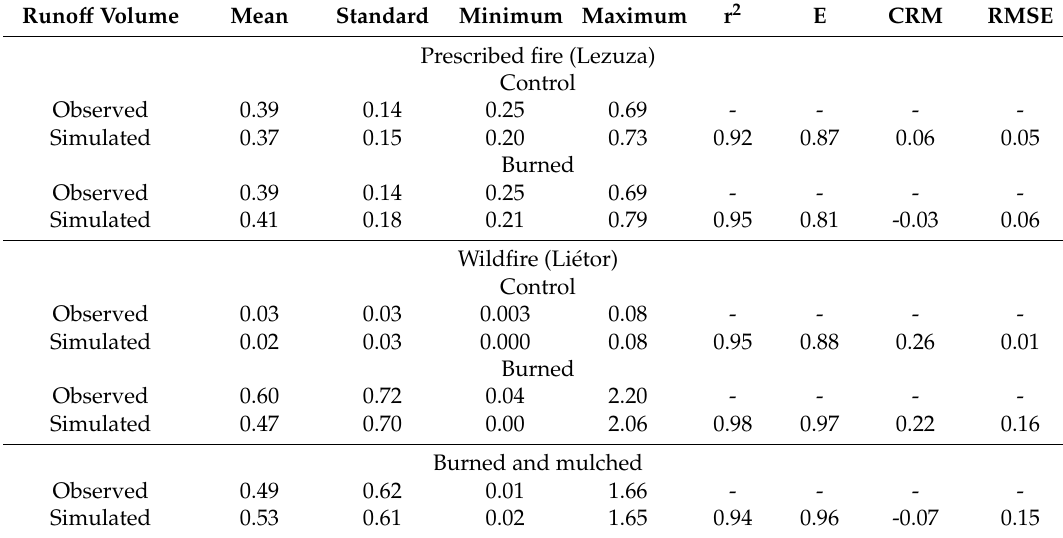
Table 6. Statistics and indexes to evaluate the runo ff prediction capacity of the curve number model in forest plots subject to prescribed fire and wildfire (Lezuza and Li é tor, Castilla La Mancha, Spain). Runo ff Volume Mean